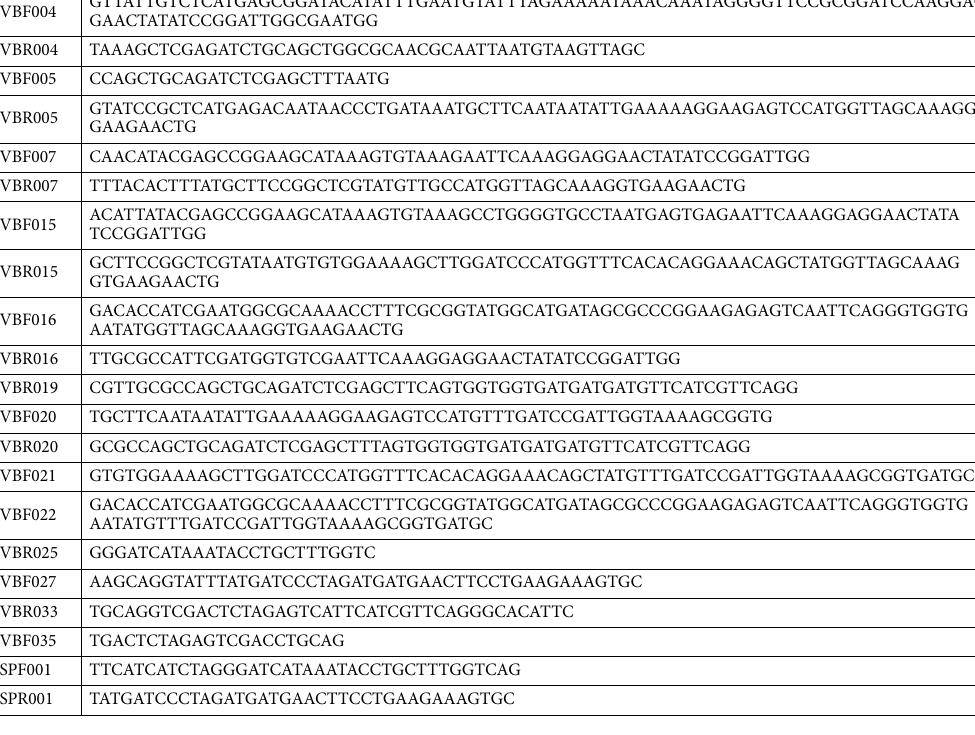
Table 2. Primers for PCR.